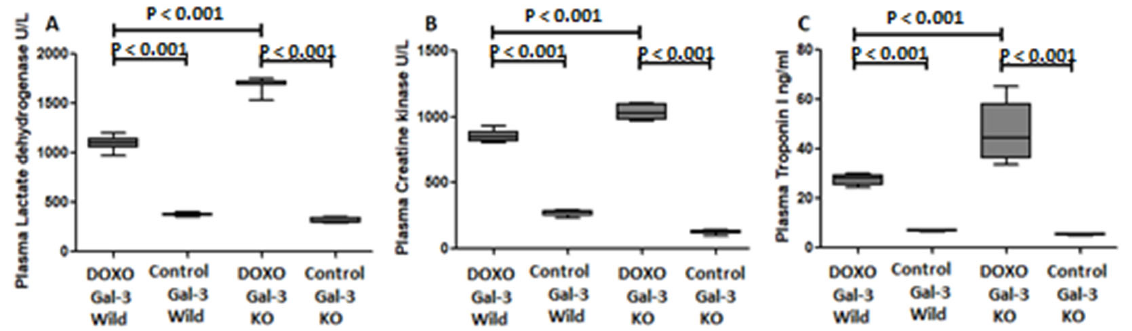
Figure 5. Expression of cardiomyocyte injury markers in DOXO-treated mice. Graphs represent plasma concentrations of ( A ) lactate dehydrogenase, ( B ) creatine kinase and ( C ) troponin I at 5 days following DOXO treatment in Gal-3 wild type and Gal-3 KO mice compared to sham-treated controls. p -values < 0.05 were considered statistically significant.